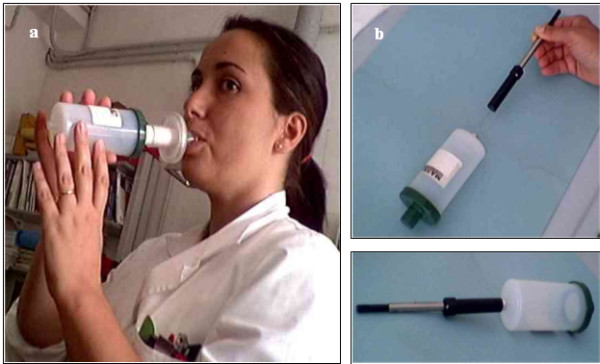
Breath collection and VOC extraction. The subjects performed a single slow vital capacity into a Teflon® bulb (Bio-VOC® breath sampler) (a) which traps the last portion of exhaled air (150 mL); the VOCs were extracted by directly inserting a 75 mm Carboxen/PDMS SPME fiber (30 min) into the bulb (b).